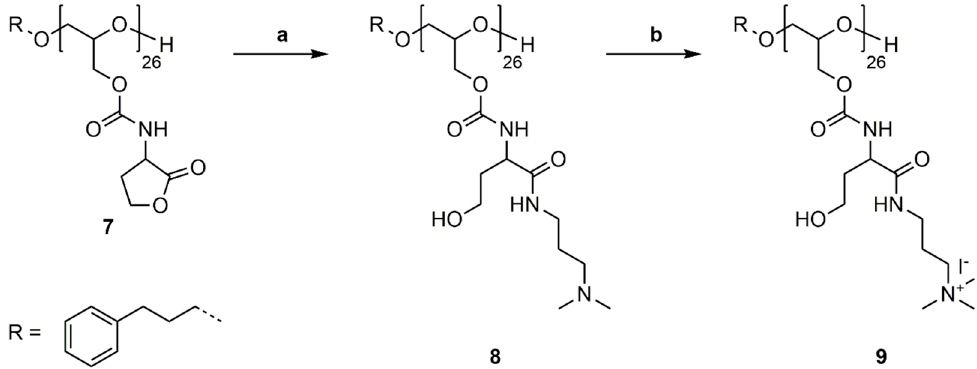
Figure 3. 1 H NMR spectrum of P(G HSL ) 26 ( 7 ) measured in DMF- d 7